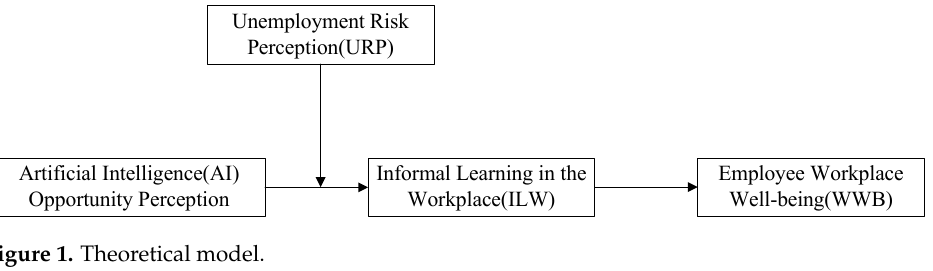
Figure 1. Theoretical model.